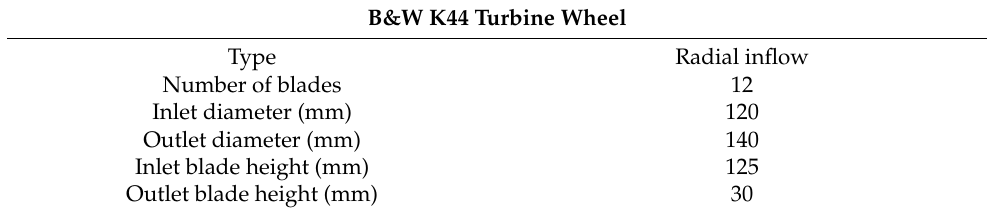
Table 1. The parameters of turbine